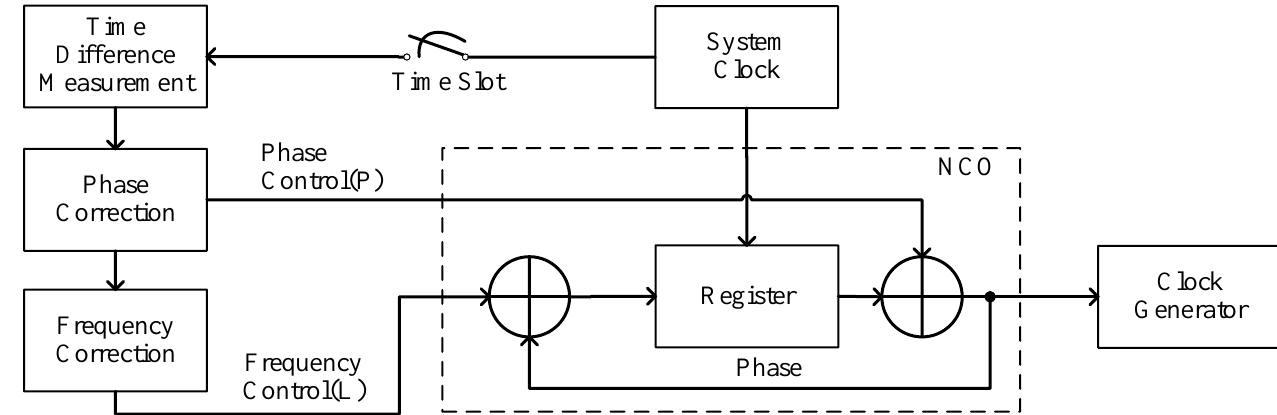
Figure 10. Clock synchronization process.